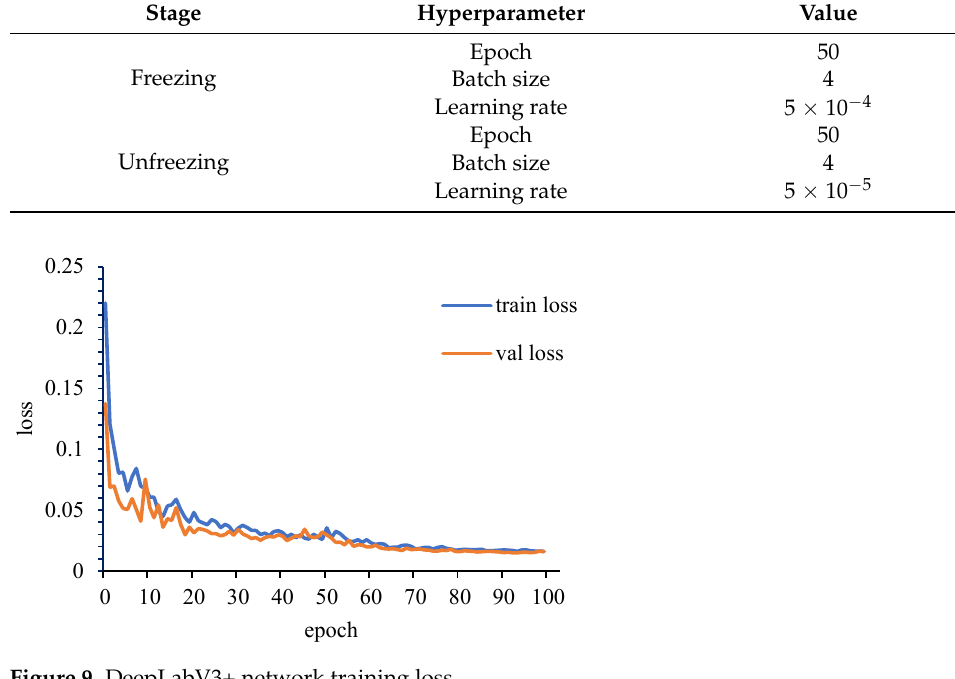
Figure 9. DeepLabV3+ network training loss. Table 3. Image segmentation confusion